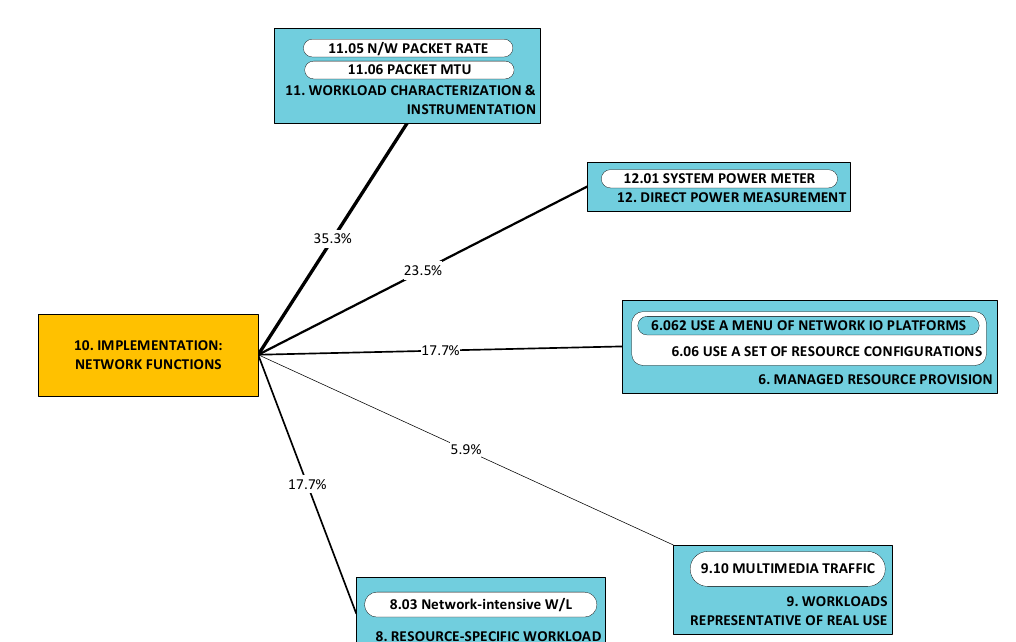
Figure 10. Approaches to solving challenges in category P10; utility metric U A is shown in line thickness and as a percentage. RUs in the respective categories are the following: P10: [48,53]; A6 [53]; A8 [53]; A9 [48]; A11 [53]; A12